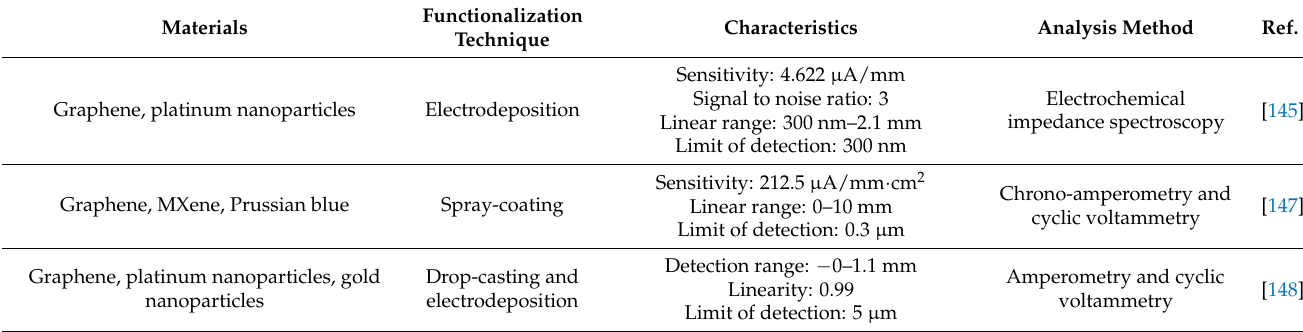
Table 4. Summary of the performances of the copper nanomaterials-functionalized LIG-based sensors.